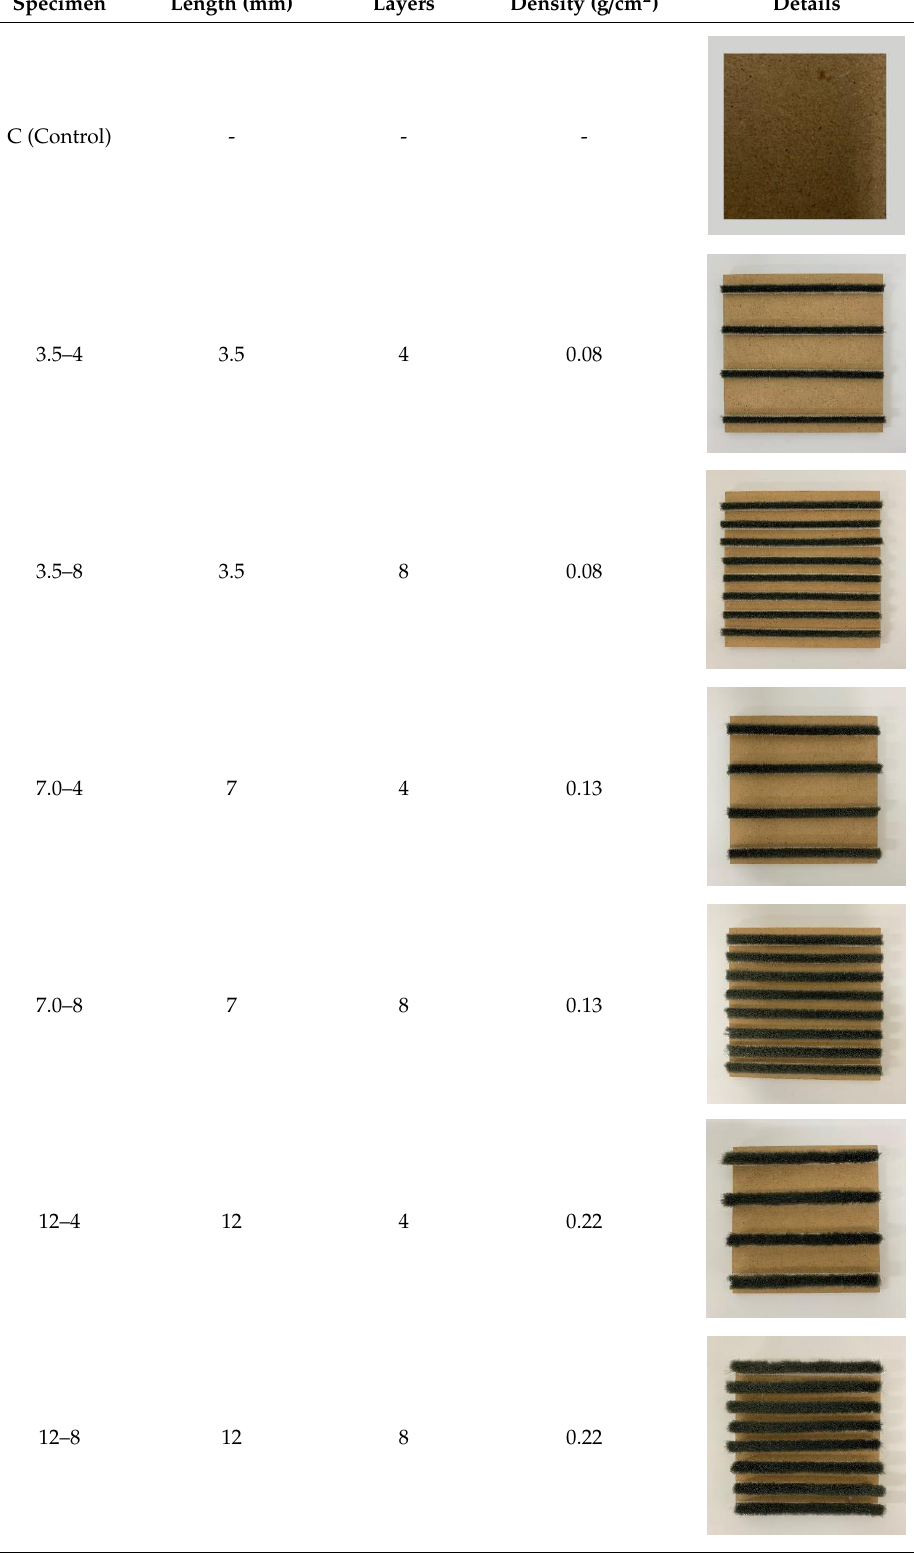
Table 2. Main parameters for evaluating the fine dust particle removal rate of the textile fabric specimens. Specimen